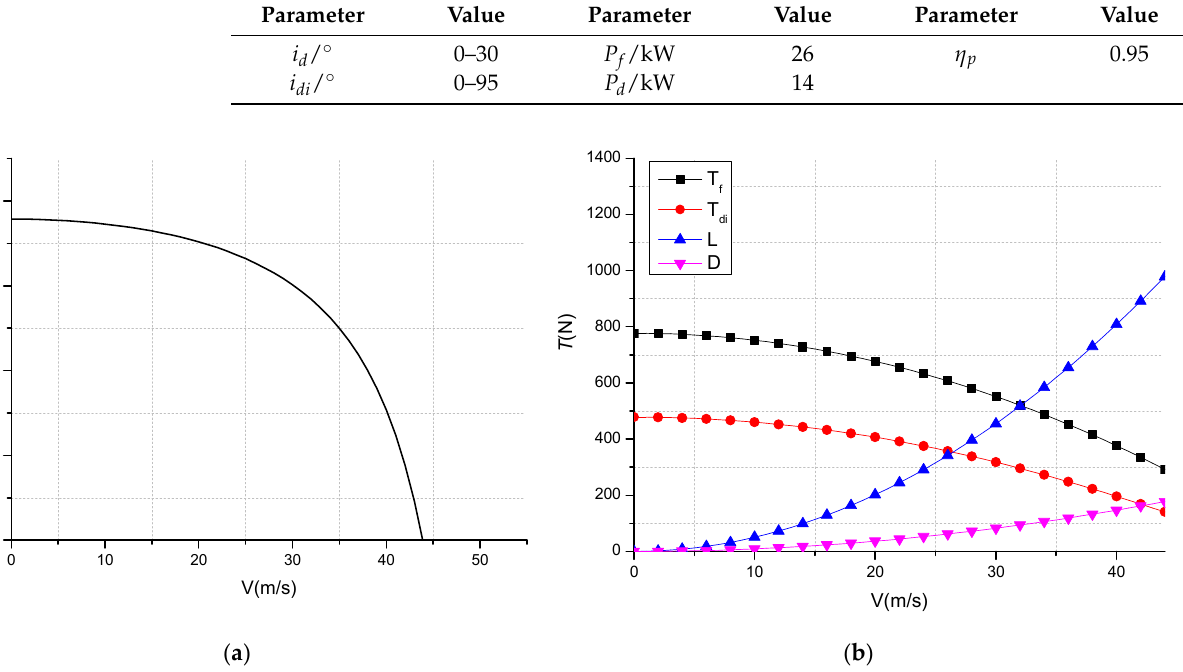
Figure 7. The calculation result of the transition corridor based on the maximum lift coefficient. ( a ) Deflection angle of ducted lift-increasing system force. ( b ) Power and lift and drag